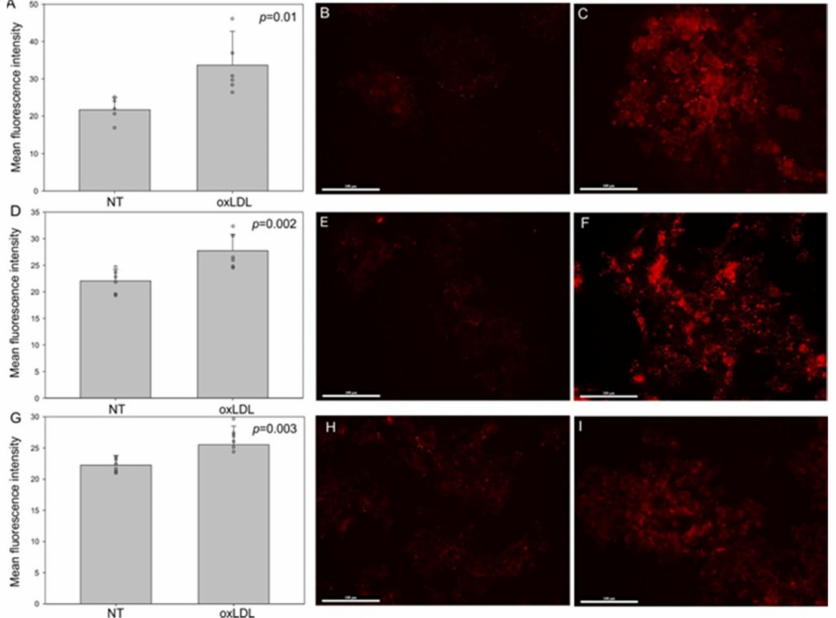
Figure 2. CD36 expression in HNC cell lines. ( A , D , G ) Mean fluorescence intensity of CD36 increased significantly under oxLDL exposure in FaDu cells ( t -test, p = 0.01, n = 6), Detroit 562 cells ( t -test, p = 0.002, n = 6) and UPCI-SCC-131 cells ( t -test, p = 0.003, n = 6) (mean ± SD; o: datapoint). ( B , E , H ) Representative immunofluorescence of CD36 in FaDu, Detroit 562 and UPCI-SCC-131 cells, respectively, without oxLDL (NT) or ( C , F , I ) treated with 30 µ g of oxLDL.